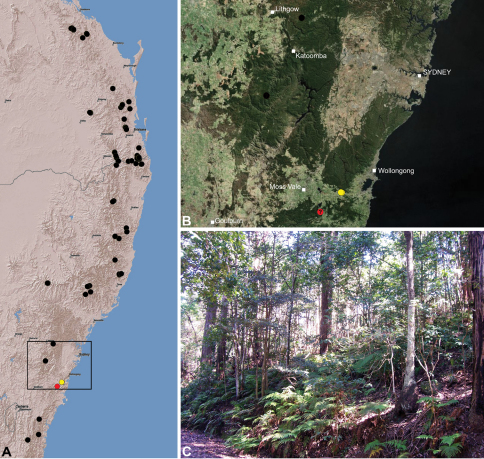
Austrarchaea helenae sp. n., distribution and habitat: A, topographic map showing the known distribution of Archaeidae in south-eastern Queensland and eastern New South Wales, with collection localities for A. helenae highlighted in yellow (red highlighted localities denote juvenile specimens of tentative identification); B, satellite image showing detail of inset (A); C, subtropical rainforest at the type locality – Macquarie Pass, Macquarie Pass National Park, New South Wales (April 2010). Image (C) by M. Rix.